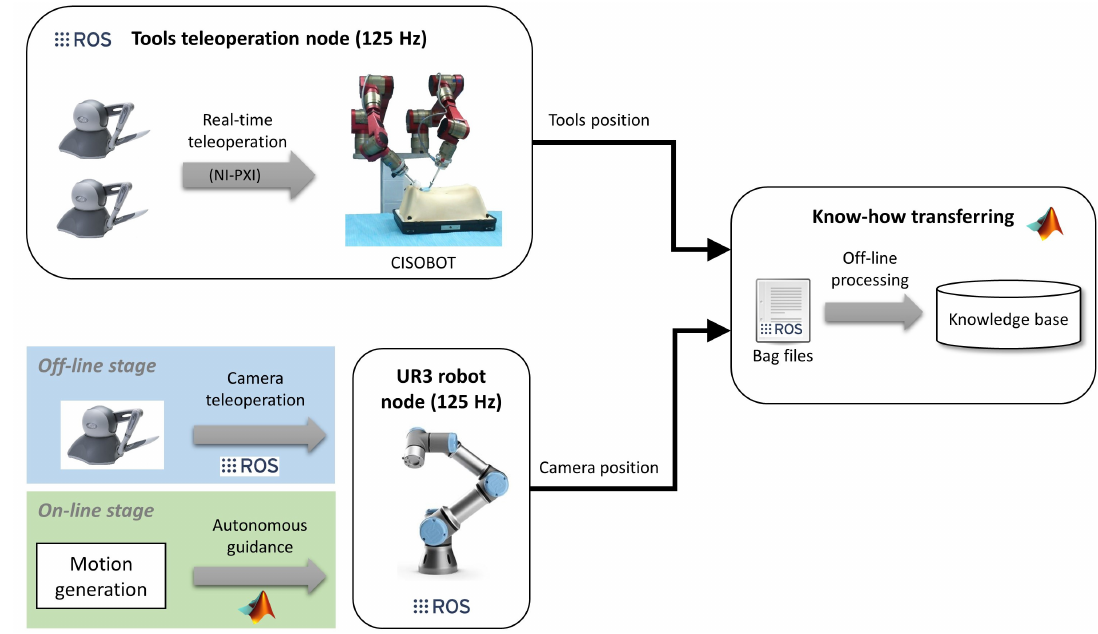
Figure 5. SW/HW architecture for the autonomous camera guidance